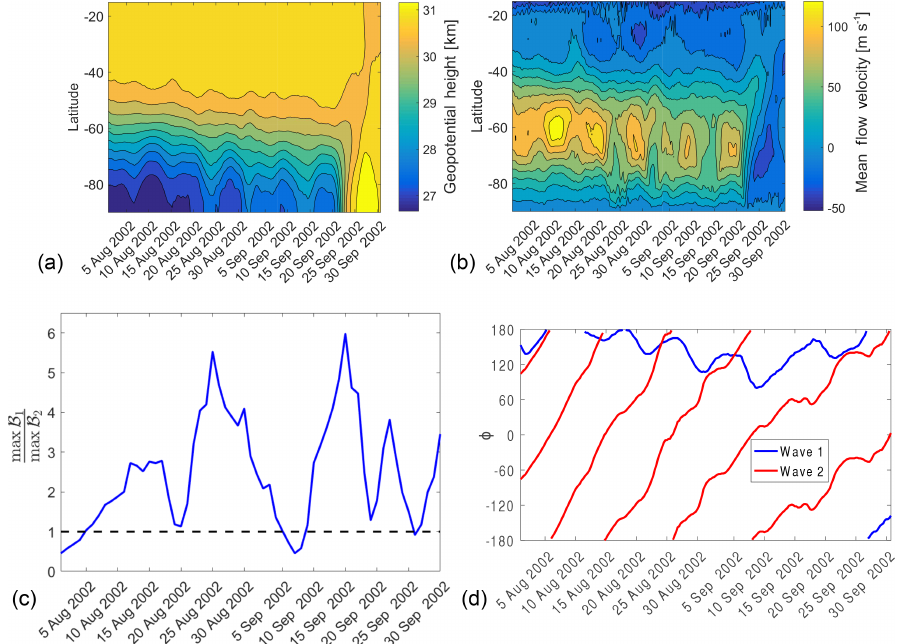
Figure 3. On the 10hPa pressure level: (a) time evolution of the geopotential height corresponding to the mean flow. (b) Time evolution of the mean flow velocity. Notice the change in wind direction from westerly to easterly that takes place from 22 to 24 September 2002. (c) Time series of the ratio of the amplitudes of waves 1 and 2. (d) Hovmöller (time–latitude) showing the position of the ridges of waves 1 and 2 at latitude 60 ◦